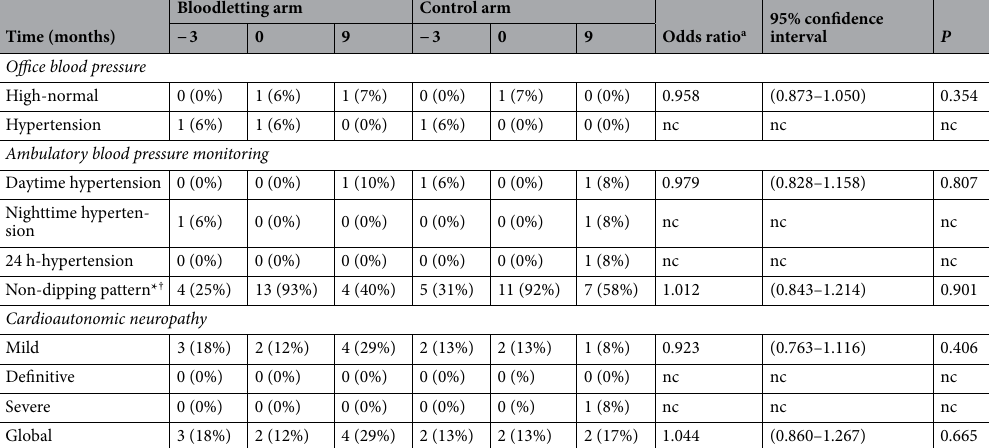
Table 3. Differences between patients allocated to scheduled bloodletting compared to those allocated to the control arm in the frequencies of abnormalities in blood pressure regulation and indexes of cardioautonomic neuropathy. Data are shown as counts (%). nc, Not computable. * P < 0.001 for comparison between visits − 3 and 0 (run-in period) when considering all women as a whole; † P = 0.002 for comparison between visits 0 and 9 (experimental period) when considering all women as a whole. a Control arm and month 0 visit were considered as reference categories in the binary logistic generalized estimating equations analyzing the experimental phase of the